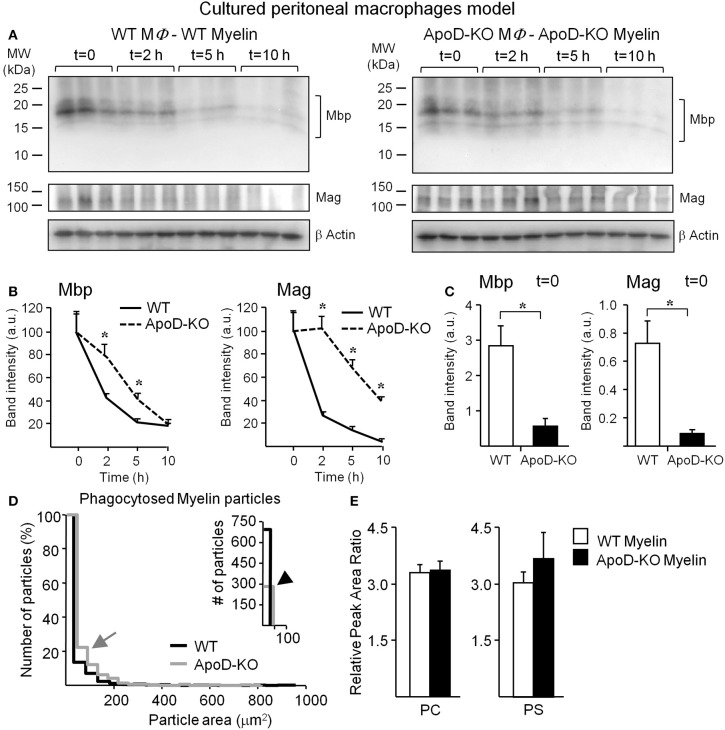
Myelin degradation by macrophages is delayed in the absence of ApoD. (A) Degradation assays in cultured macrophages exposed for 60 min to myelin of either WT or ApoD-KO genotype followed by immunoblot analyses of Mbp and Mag at four time points after removal of myelin. (B) Band densitometry of Mbp and Mag normalized to β-actin along the four time points explored, and percentually referred to t = 0. Average and s.e.m. of three macrophage samples are shown. (C) Band densitometry of Mbp and Mag at t = 0 normalized to β-actin. (D) Size distribution of phagocytosed particles of WT and ApoD-KO myelin referred as a percentage of total number of myelin particles. Right inset shows the number of particles with area <50 μm2. Four myelin phagocytosis experiments (6–8 10× fields/experiment) were analyzed for each myelin genotype. (E) UPLC-MS analysis of phosphatidylcholines (PC) and phosphatidylserines (PS) in WT and ApoD-KO myelin preparations. The plots represent the average ± SD of 6 independent myelin preparations, each extracted from two brains/genotype. Statistical differences were assayed by ANOVA followed by a Multiple Comparison Holm-Sidak test (B), and Student's t-Test (C,E). Asterisks show statistically significant differences (P < 0.05).